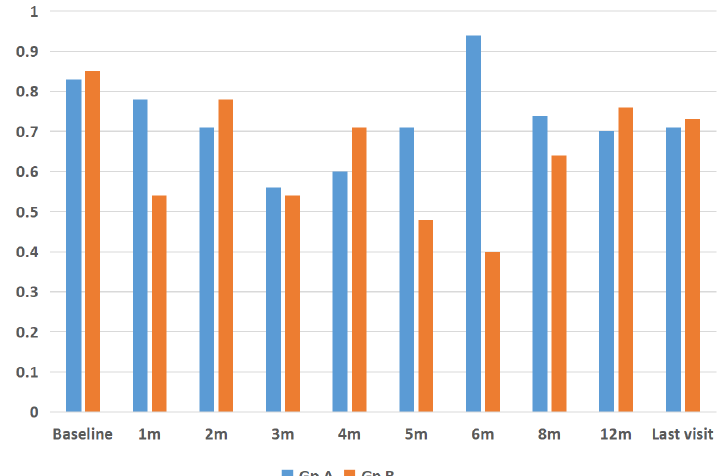
Figure 5: Comparison of changes in logMAR visual acuity after Ozurdex ® injection for refractory diabetic macular edema in phakic and pseudophakic eyes at baseline